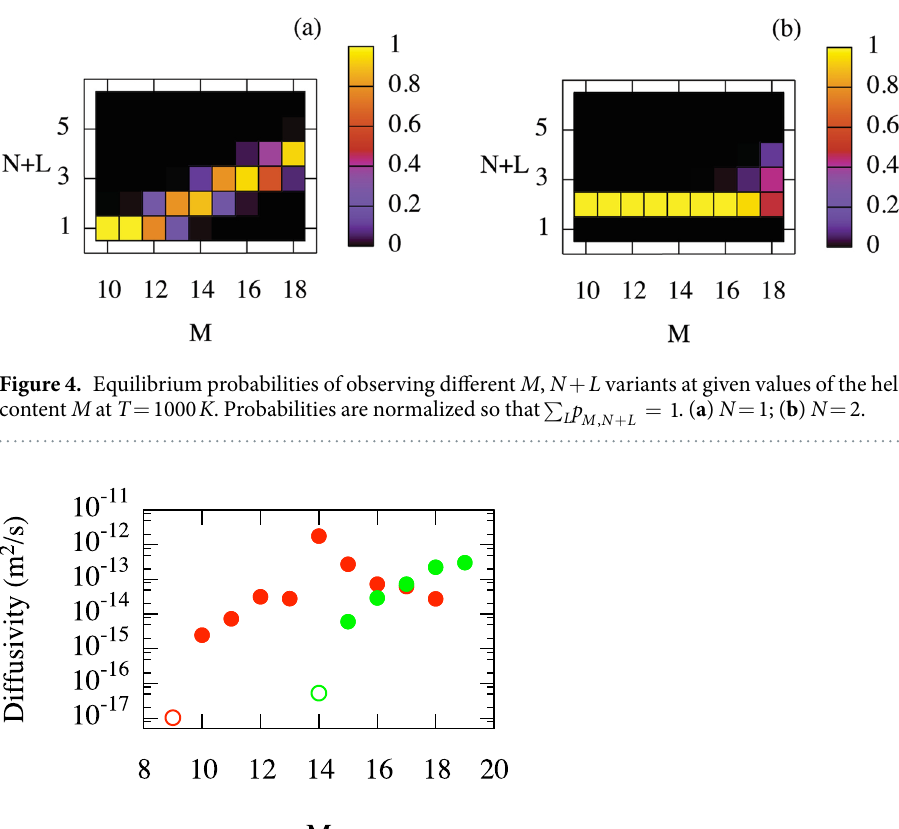
Figure 5. Diffusivity high helium content V N He M complexes at T = 1000 K as estimated from kinetic Monte Carlo simulations informed by ParSplice simulations. Red: N = 1; Green: N = 2. Filled symbols correspond to estimates of the diffusivity, while open symbols are upper bounds at a 90% confidence level for cases where the complexes did not diffuse on accessible simulation